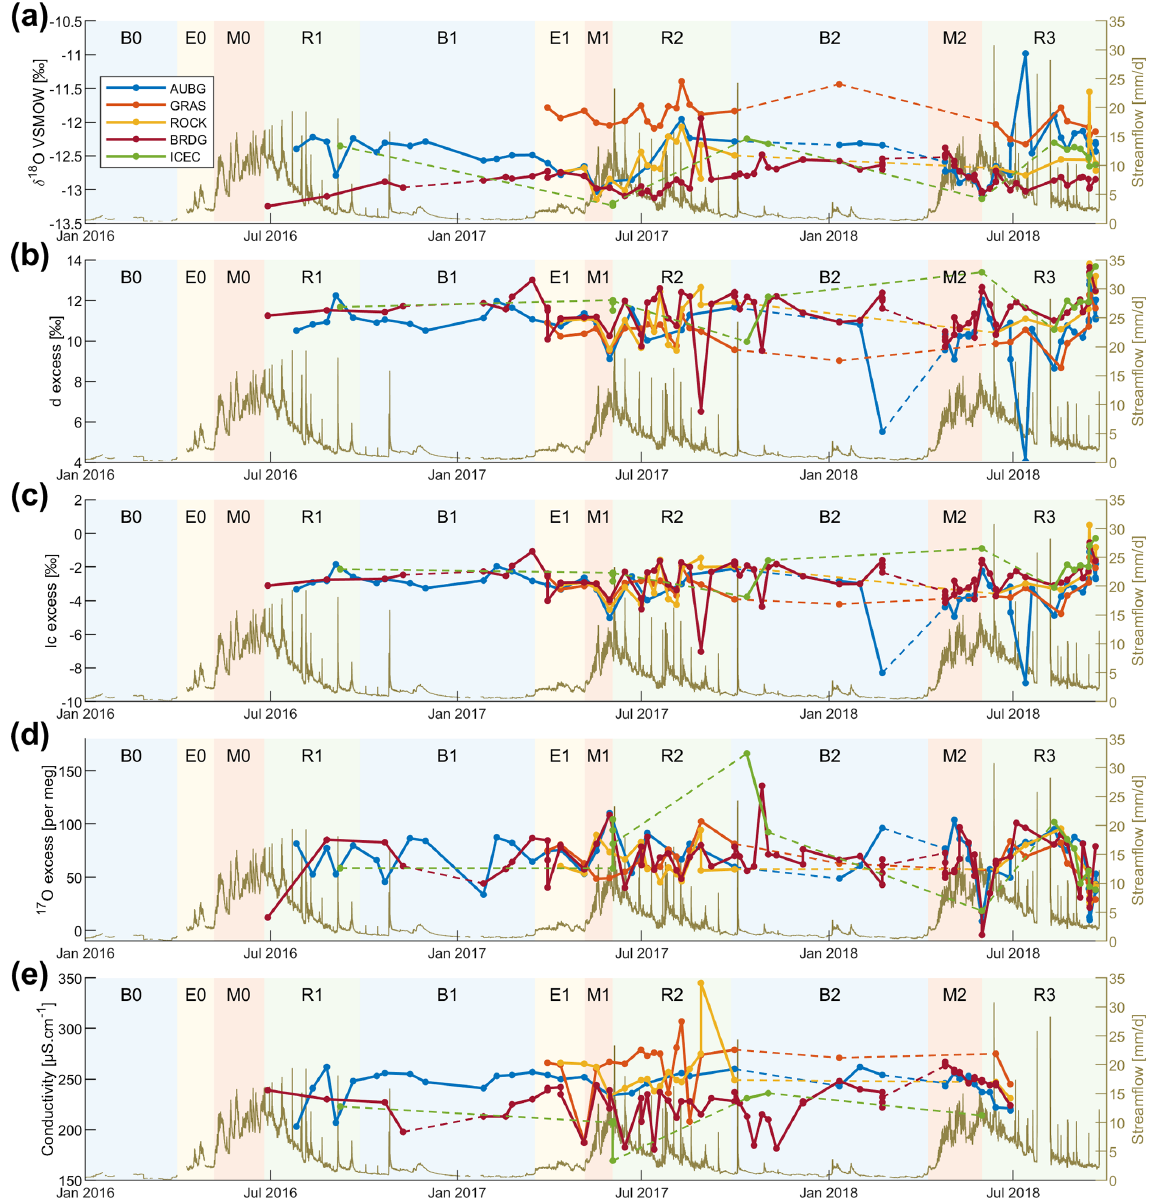
Figure 5. Time series of δ 2 H, δ 17 O, δ 18 O, conductivity, d-excess, lc-excess, and 17 O-excess for five springs (location on map Fig. 1a). We connect the dots to facilitate visualization since there are five separate springs